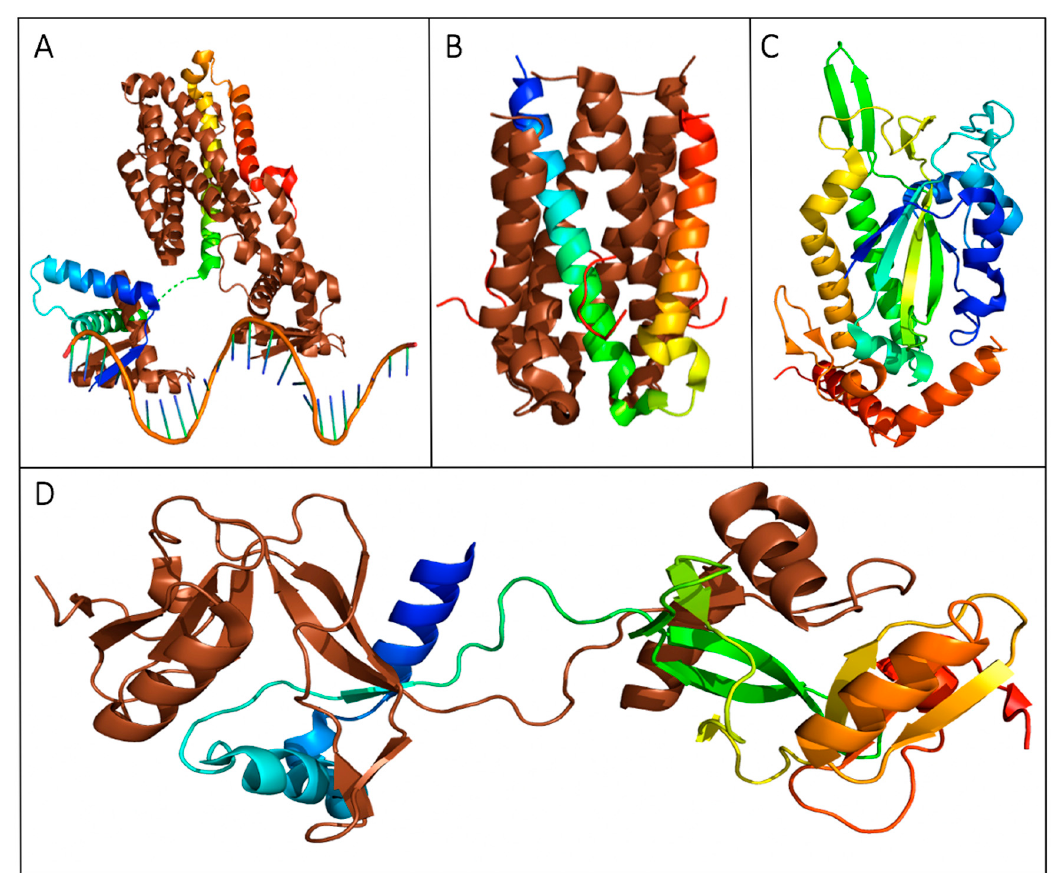
Figure 5. Crystal structures of transferosome proteins from the F ( A – C ) and pED208 ( D ) plasmids. The structures represented with oligomeric states have a monomeric unit expressed as chainbows with the remaining homo multimers represented in brown. ( A ) TraM binds three specific DNA sequences, sbmA , sbmB and sbmC [137]. The crystal structure of the TraM- sbmA interaction shows cooperative binding is facilitated by DNA distortion, allowing simultaneous binding by both tetramers while still allowing multiple contact points for TraD (PDB ID: 3ON0). ( B ) The crystal structure of the TraD–TraM interaction (PDB ID: 3D8A) [139]. TraM forms a tetrameric binding protein as represented by the monomer chainbow and the brown tetramer chains, while TraD peptides are represented in red. The C-terminal residue of TraD Phe717 binds to the hydrophobic pocket produced by TraM residues Leu85, Val106, and Ile109. ( C ) The solved crystal structure of the F plasmid TraI relaxase NTD represented in chainbows, with 10 α -helices and 13 β -strands (PDB ID: 1P4D) [134]. ( D ) The CTD of TraI forms an intertwined tetramer with two domain swapped dimers; one dimer is depicted above (PDB: 3FLD) [132]. TraI expresses a fold with a compact α - β domain at the CTD connected to two α -helices at the NTD by a proline-rich loop.